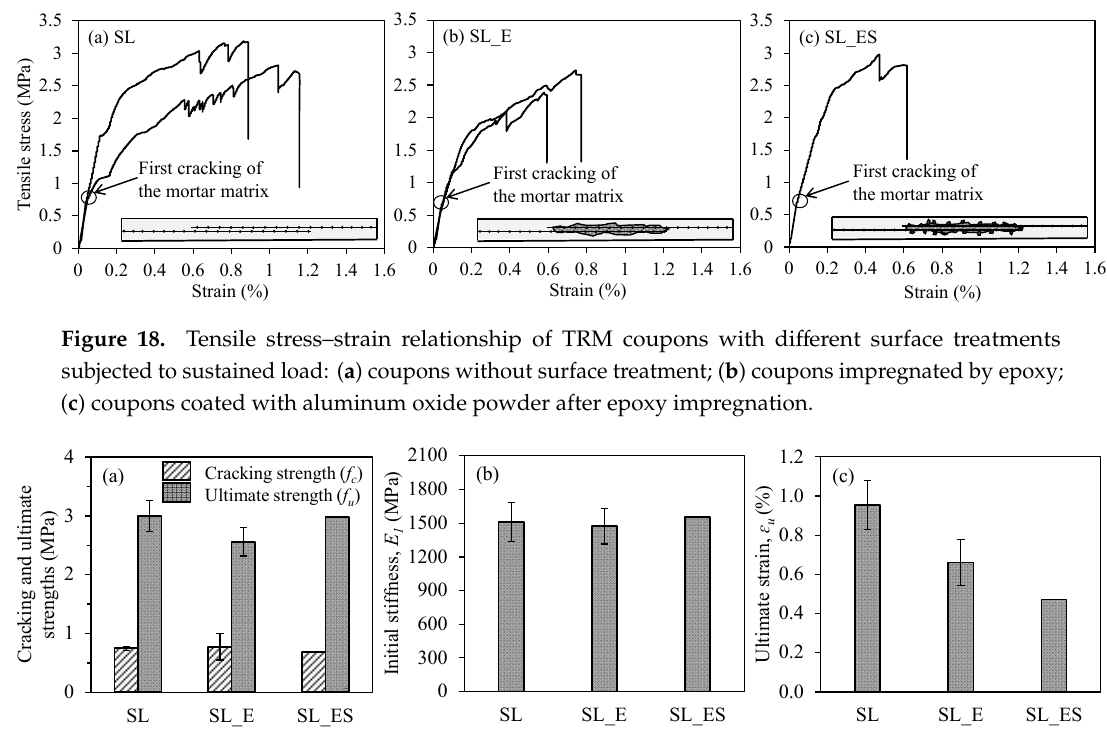
Figure 20. Tensile stress–strain relationship of TRM coupons subjected to sustained load: ( a ) coupons without surface treatment; ( b ) coupons impregnated by epoxy; ( c ) coupons coated with aluminum oxide powder after epoxy impregnation. 4. Conclusions This study investigated the effect of harsh conditions on the tensile behaviors of TRM coupons. To simulate various types of harsh conditions, a chloride environment, high temperature and humidity environment, and sustained load were used. Two different details in the lap-spliced zone, including impregnation by epoxy and coating aluminum oxide powder after epoxy impregnation on carbon fiber textile, were applied to enhance the mechanical characteristics of TRM coupons. Besides